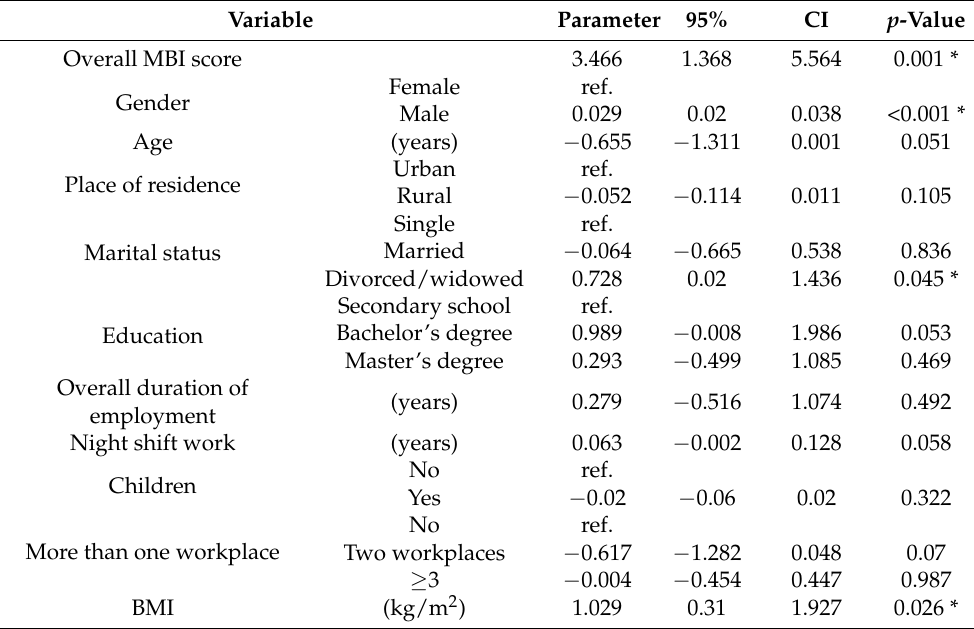
Table A1. The multifactorial linear regression of the Karolinska Sleepiness Scale (KSS).